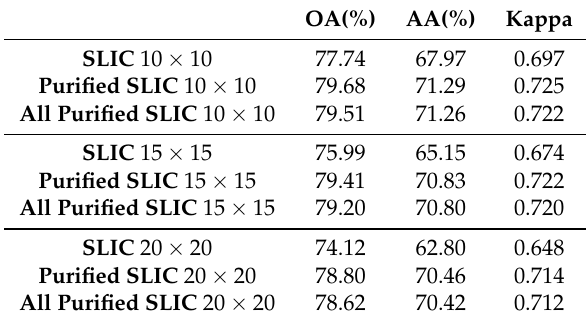
Figure 10. The detail segmentation maps and classification maps of three plots in which obvious mixed SLIC superpixels are purified. Table 3. Average classification accuracy in ten runs of